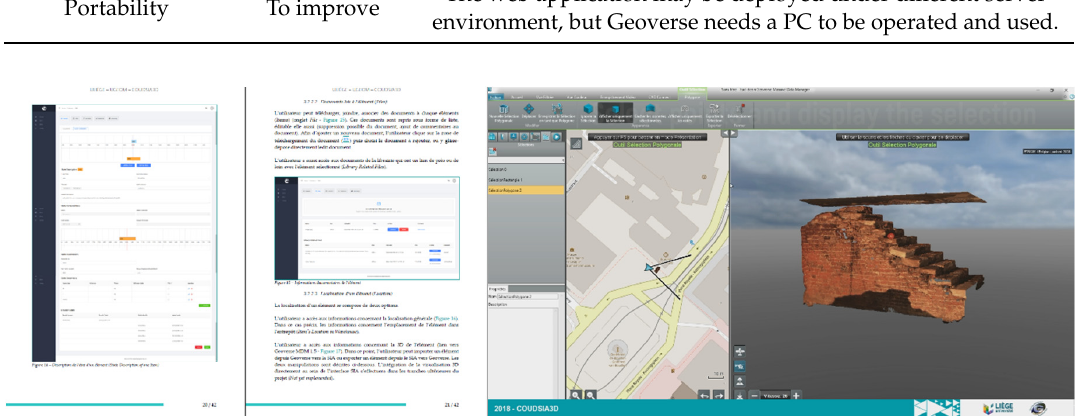
Figure 24. Extract of the user manual and video tutorial for the end users.